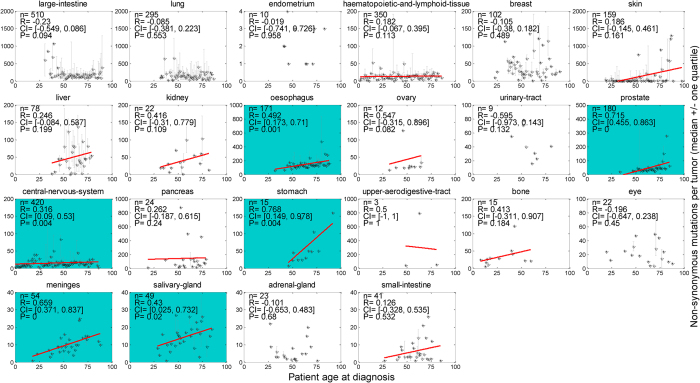
Spearman rank correlation between mutations per tumor sample and patient age at diagnosis for individual cancer types.Stars and bars stand for median and quartiles, respectively. Cancers with positive correlation coefficients are illustrated by solid fitting line, and cancers with P < 0.05 are encoded by dark background. n = number of samples; R = correlation coefficient; CI = 95% confidence interval; P = p-value.